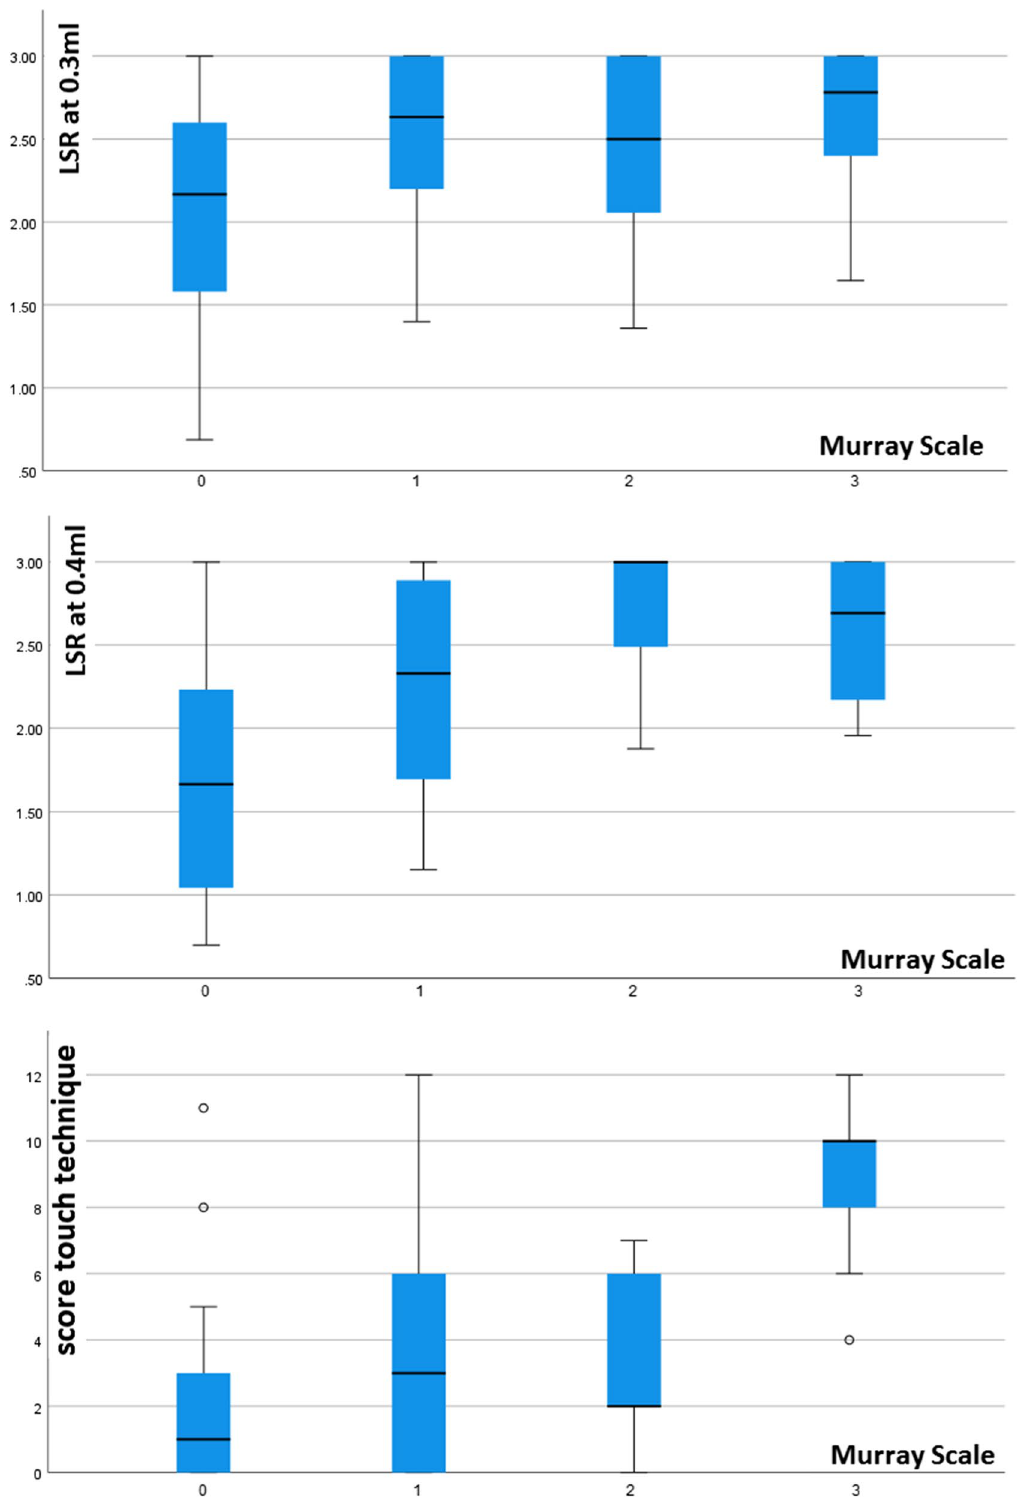
Fig. 3 Distribution of latency of swallowing response (LSR) or touch‑sum score for each Murray Secretion Scale level visualized in